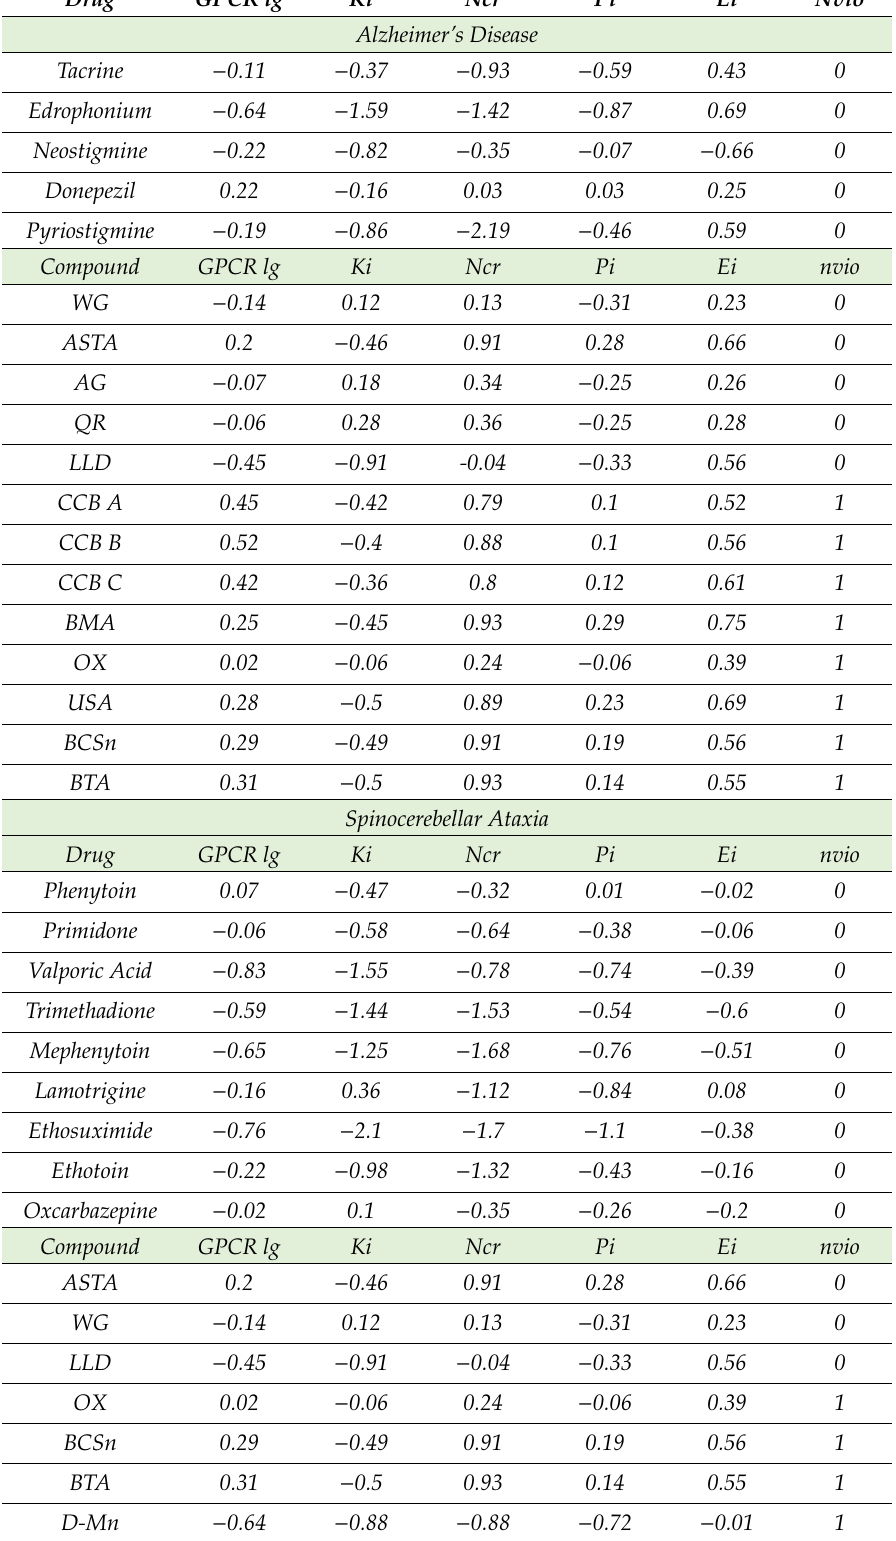
Table 4. Comparison of Drug and Novel